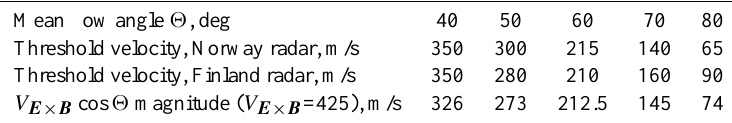
Table 1. STARE echo onset: smallest l-o-s electron velocity as a function of the flow